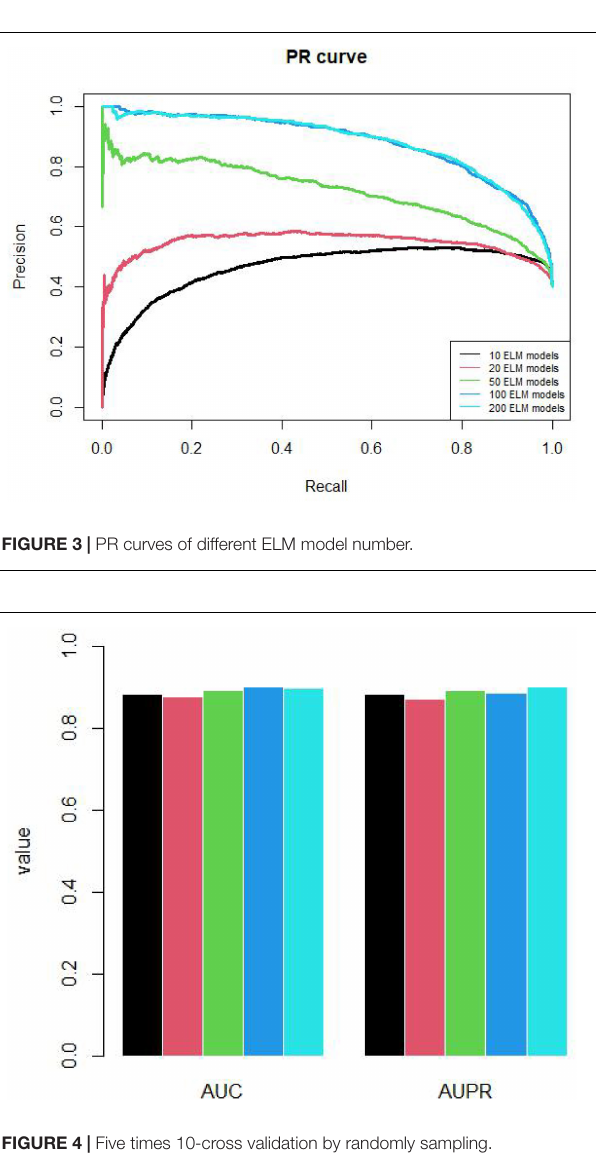
FIGURE 4 | Five times 10-cross validation by randomly sampling.